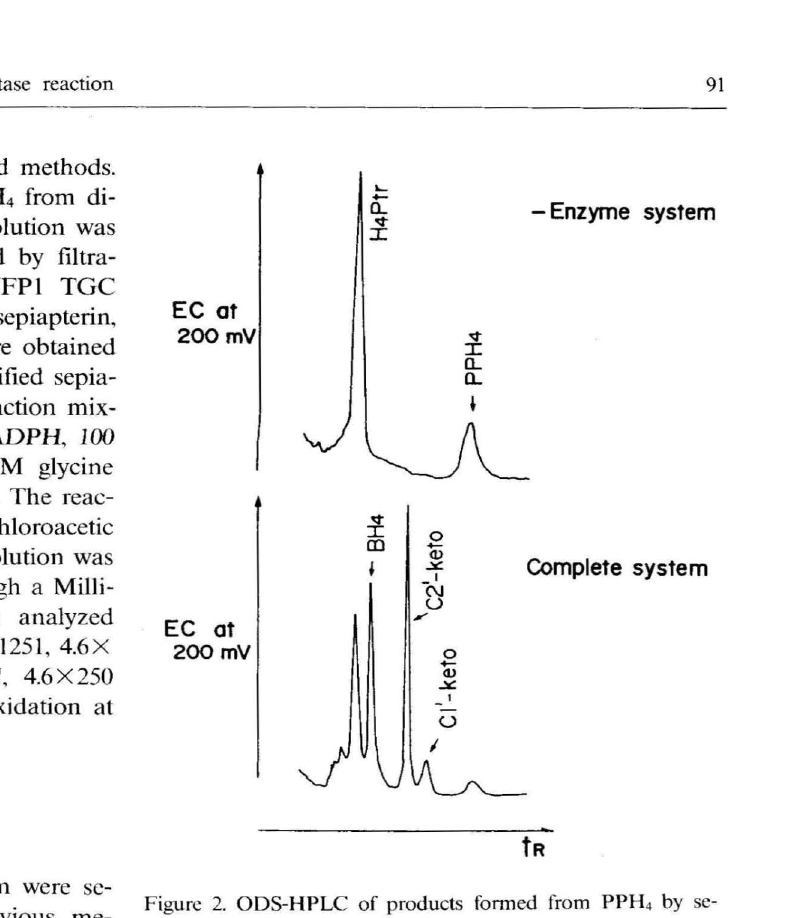
Figure 2. ODS-HPLC of products formed from PPH 4 by se piapterin reductase at pH